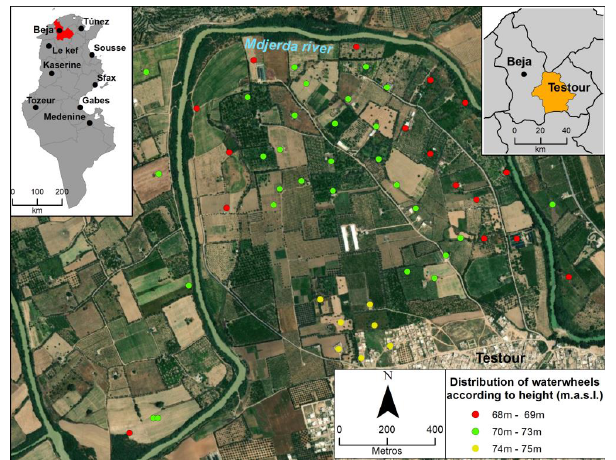
Figure 1. Spatial distribution according to height of the waterwheels identified in Testour and based on land registry parcels produced by the Topographical Service of the French Protectorate of the Tunisian Government in 1936.